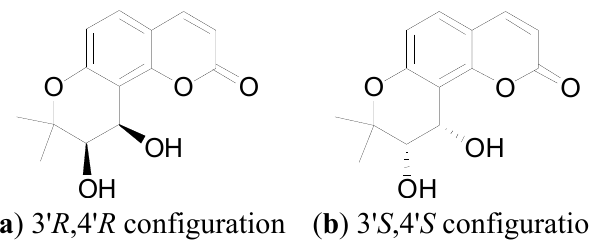
Figure 1. Structures of cis -khellactone with ( a ) 3' R ,4' R or ( b ) 3' S ,4' S configuration.